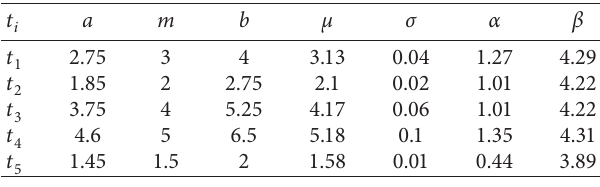
Table 3: PERT-beta distribution parameters of the advising